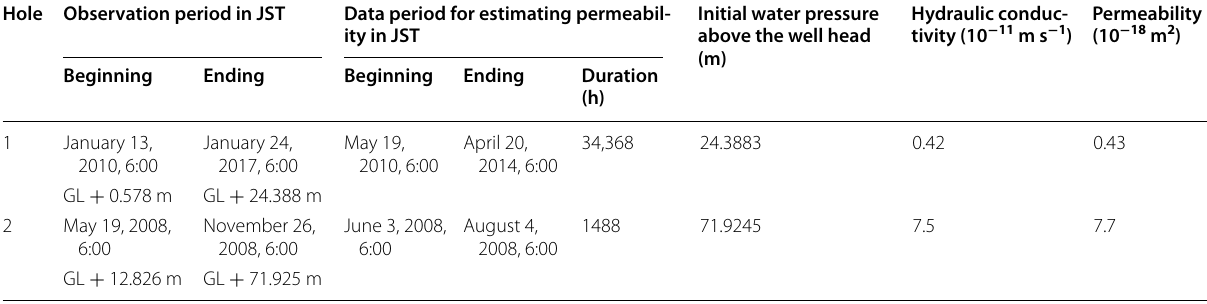
Table 5 Observation period, data period, and initial water pressure for the trials of permeability estimation using natural recovery of background water pressures in both Holes 1 and 2 Hole Observation period in JST